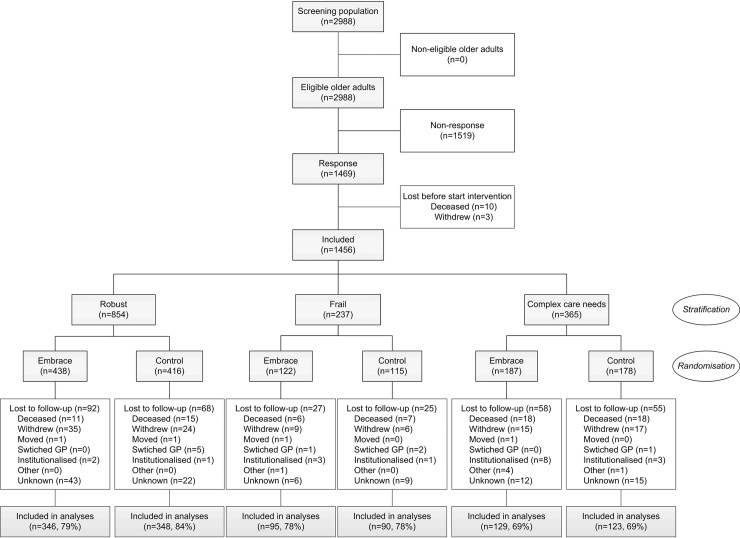
CONSORT flow diagram of the Embrace study.